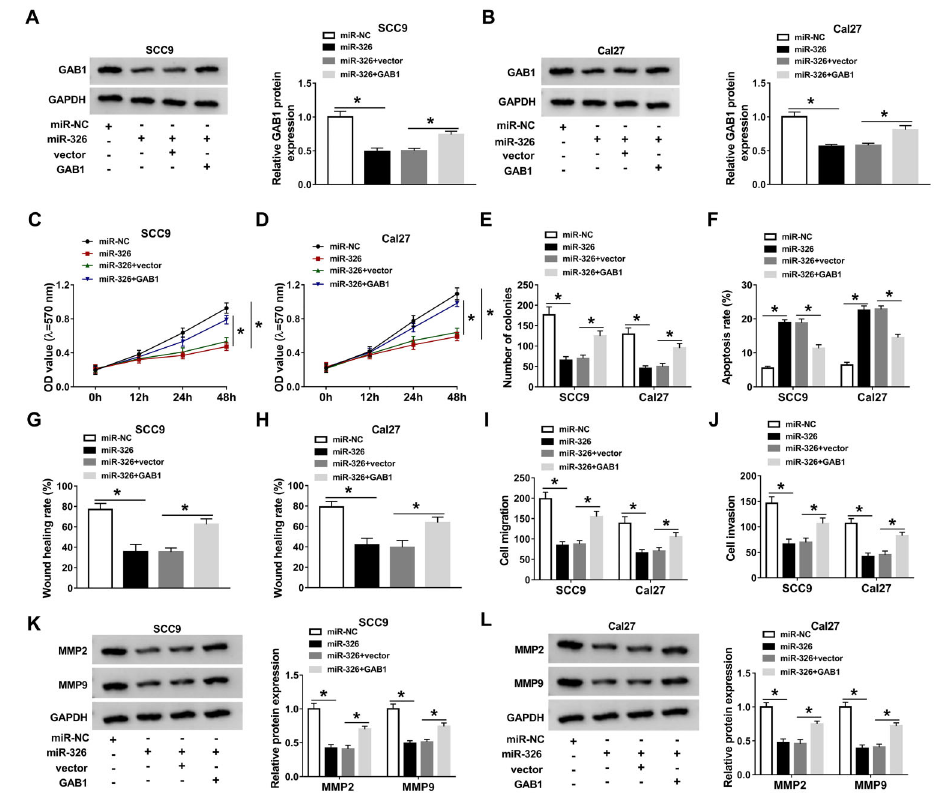
Figure 6. GAB1 downregulation was accountable for miR-326 as a tumor inhibitor in oral squamous cell carcinoma (OSCC). A and B , GAB1 protein analysis was conducted by western blot in SCC9 and Cal27 cells transfected with miR-NC (negative control), miR-326, miR-326 + vector, and miR-326 + GAB1. Cell growth was determined by cell viability via MTT ( C and D ) and clonal capacity via colony formation assay ( E ). F , Flow cytometry was used for assessing apoptotic cells. Wound healing assay, transwell assay, and western blot were used to assess cell migration ( G – I ) and invasion ( J – L ). Three biological and three technical replicates were performed in each assay. Data are reported as means ± SD. *P o 0.05 (one-way ANOVA followed by Tukey ’ s test).